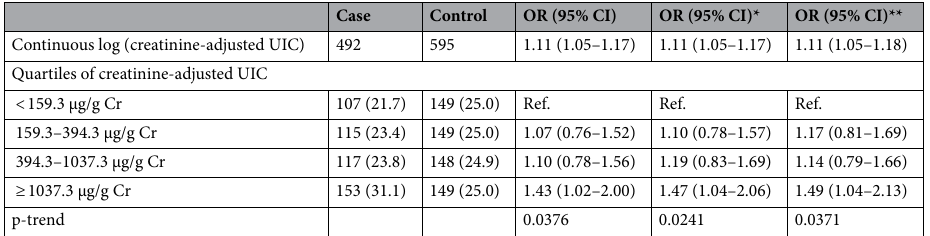
Table 2. The odds ratios (ORs) and 95% confidence intervals (CIs) of the risk of PTC for creatinine-adjusted UIC among 492 case patients with PTC and 595 control patients with benign thyroid diseases at Samsung Medical Center in South Korea between 2011 and 2016. PTC papillary thyroid cancer, UIC urinary iodine concentration. *Adjusted for age and sex. **Adjusted for age, sex, education level, physical activity, supplement intake, BMI, daily alcohol intake, smoking status, family history of cancer, and history of benign thyroid diseases.